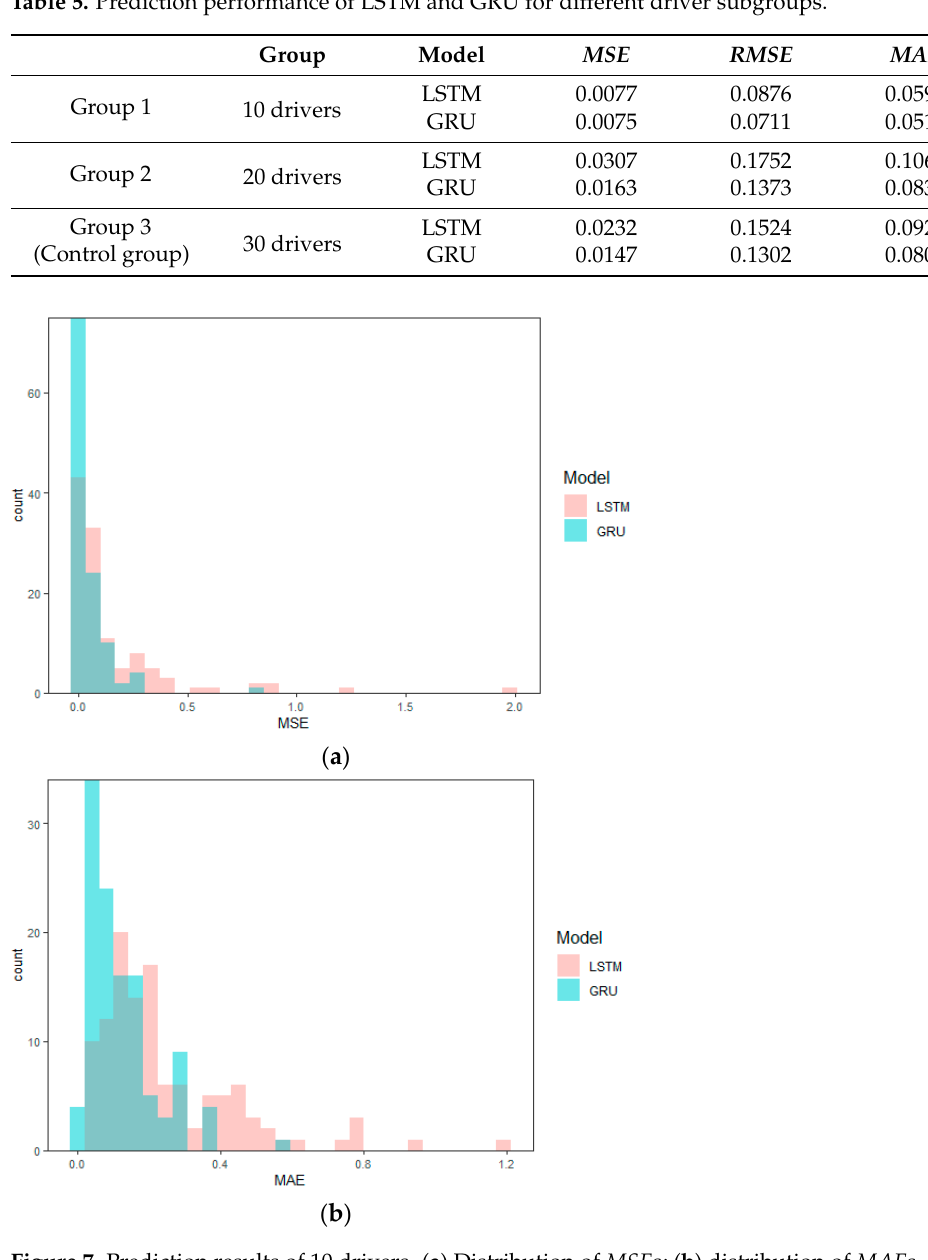
Figure 7. Prediction results of 10 drivers. ( a ) Distribution of MSEs; ( b ) distribution of MAEs. Table 5. Prediction performance of LSTM and GRU for different driver subgroups.